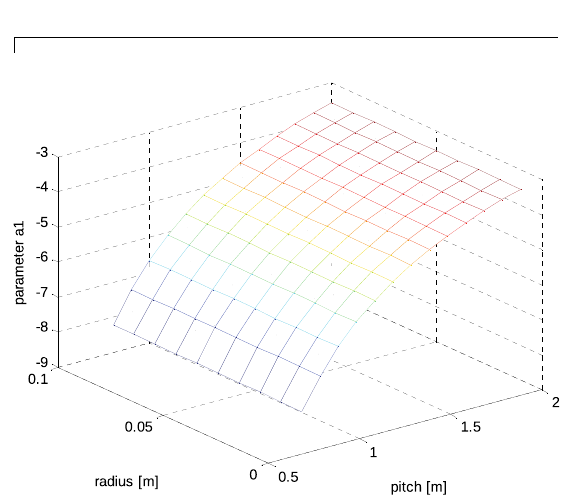
Figure 3. Parameter a 1 versus radius α and pitch p of the